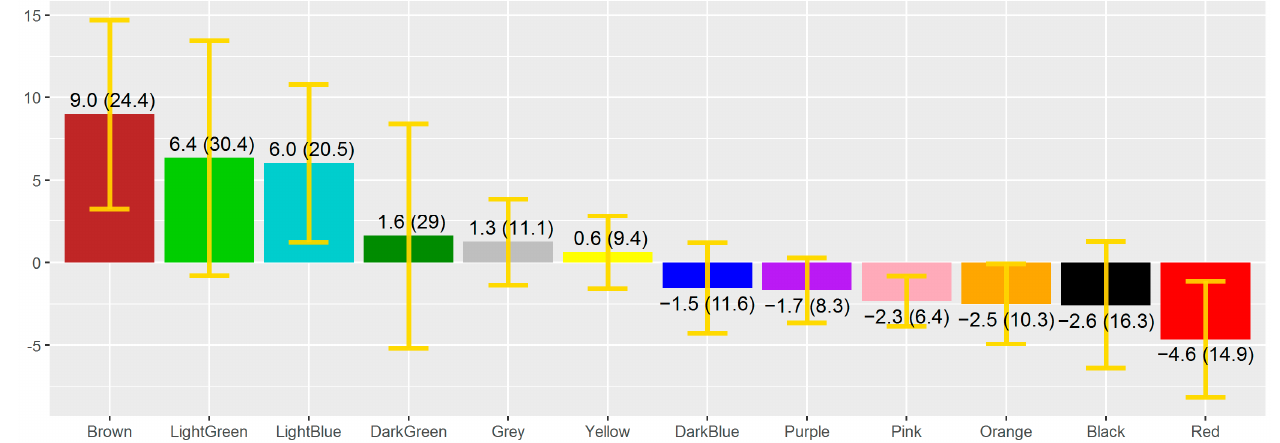
Figure 1. Mean difference between the coloured area (standard deviation) for each of the 12 colours available to children in the pictorial activities of 2021 and 2019 (cm 2 ) and confidence interval for the mean difference (95%).